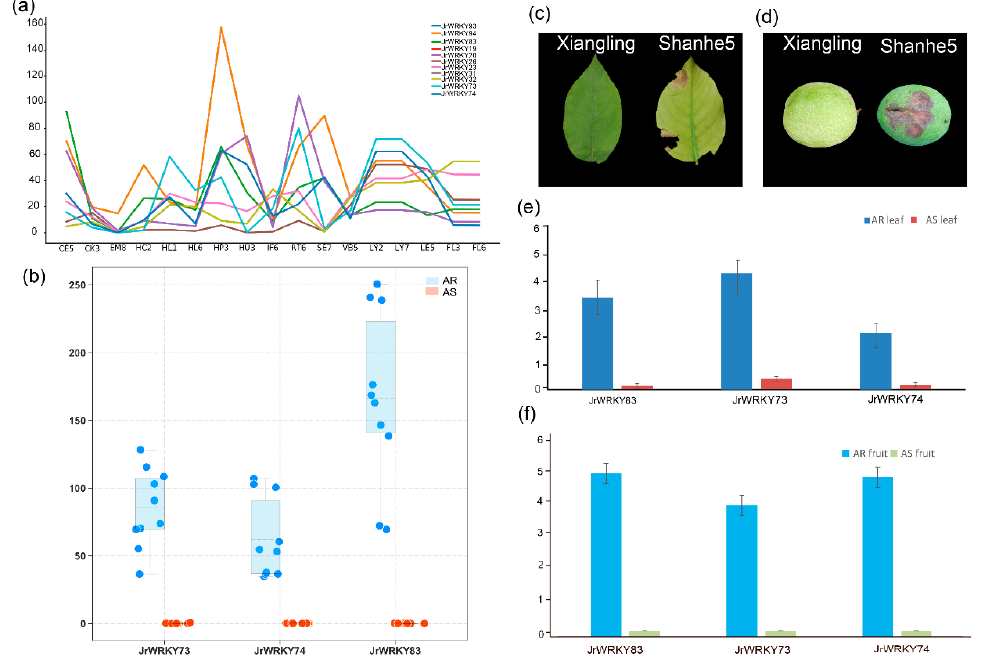
Figure 8. The expression profile of WRKY gene family in walnut: ( a ) the highly expressed genes among different tissues of walnut; IF6: immature fruit; FL3: pistillate flower; FL6: mature pistillate flower; EM8: embryo; SE7: somatic embryo; VB5: vegetative bud; CE5: callus exterior; CK3: catkins; HC2: hull cortex; HU3: immature hull; HL1:immature hull; HL6: young hull ; HP3: hull peel; LY2: immature leaf; LY7: young leaf; LE5: mature leaves; RT6: root. ( b ) Mean box plot of WRKY members between anthracnose-resistant F26 fruits (AR) and anthracnose-susceptible F423 fruits (AS); each black circle represents each sample. ( c,d ) The morphology of walnut leaf (resistance (Cultivar Xiangling) and non-resistance (Cultivar Shanhe5)) and fruit (resistance (Cultivar Xiangling) and non-resistance (Cultivar Shanhe5)). ( e,f ) Relative expression levels of WRKY genes in walnut leaf (resistant cultivar Xiangling and non-resistant cultivar Shanhe5, and fruit resistant cultivar Xiangling and non-resistant cultivar Shanhe5).